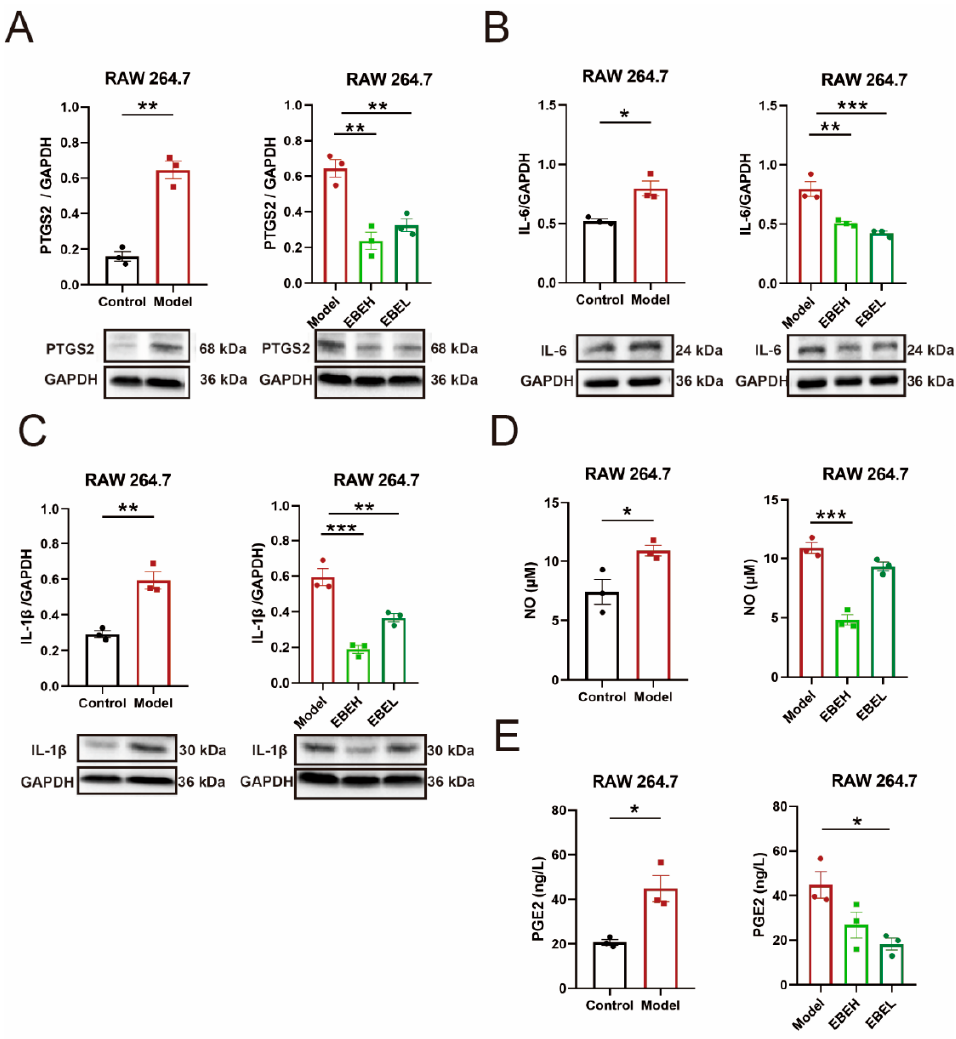
Figure 6. EBE attenuated inflammation of cells model by PTGS2. ( A – E ) PTGS2 ( A ), IL-6 ( B ), IL-1 β ( C ), NO ( D ) and PGE2 ( E ) expression of cells for RAW 264.7 of vehicle treatment (Control), RAW 264.7 of LPS (Model), model of 50 µ g/mL EBE treatment (EBEH), and model of 12.5 µ g/mL EBE treatment (EBEL). ( A – C ) were measured by western blotting. Unpaired t -test and ordinary one-way ANOVA were used on experimental data. Data are presented as mean ± SEM, n = 3. * p < 0.05, ** p < 0.01, *** p <